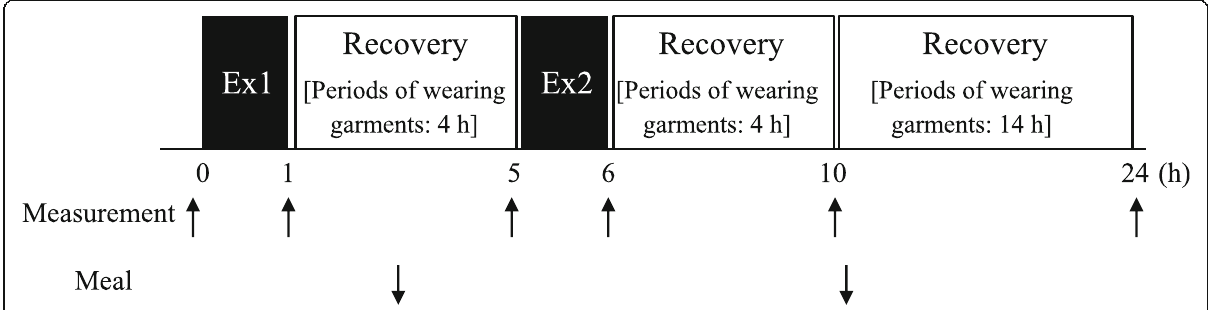
Fig. 1 Timeline of measurements and meal consumption. All subjects performed two bouts of exercise sessions (Ex1, Ex2) with wearing normal garment, while they kept wearing either CG (CG trial) or normal garment (CON trial) during the recovery